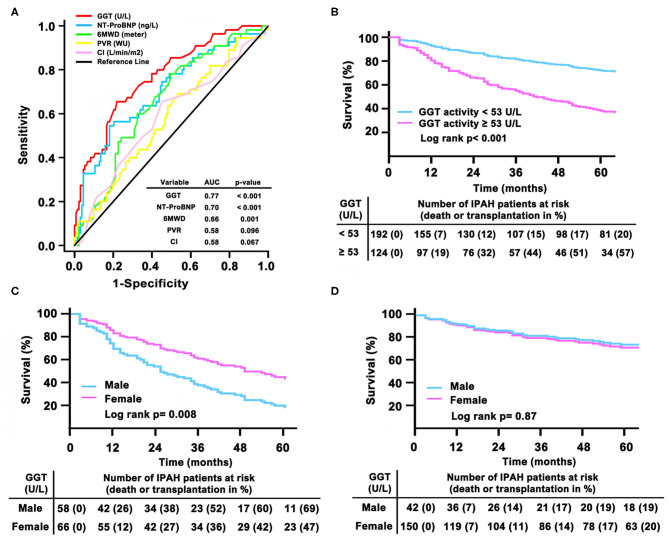
Gamma-glutamyltranspeptidase (GGT) in relation to other markers of adverse prognosis by (A) receiver operation characteristic analysis; (B) Kaplan– Meier survival curves according to the baseline cut-off serum GGT activity in total patients; (C) survival in different sex in GGT activity ≥ 53 U/L group and (D) in GGT activity <53 U/L group. AUC, area under the curves; CI, cardiac index; IPAH, idiopathic pulmonary arterial hypertension; 6MWD, 6-minute walking distance; NT-proBNP, N-terminal pro B-type natriuretic peptide; PVR, pulmonary vascular resistance.